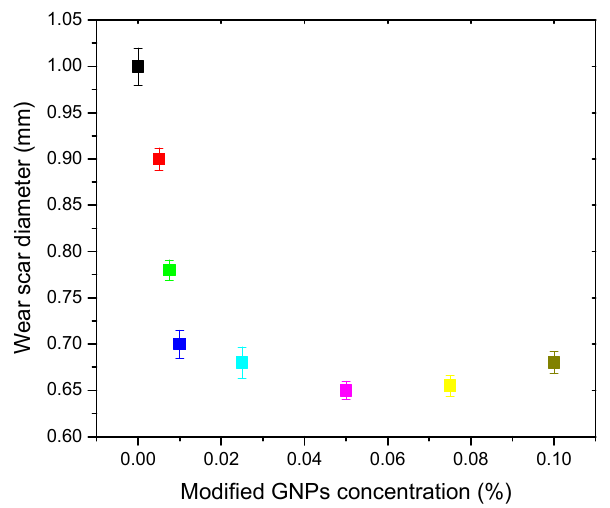
Figure 6. The tribological performance of the engine lubricant oil upon addition of various modified GNPs concentrations. Table 1. Comparison of the tribological performance between the modified GNPs and those of previous works.